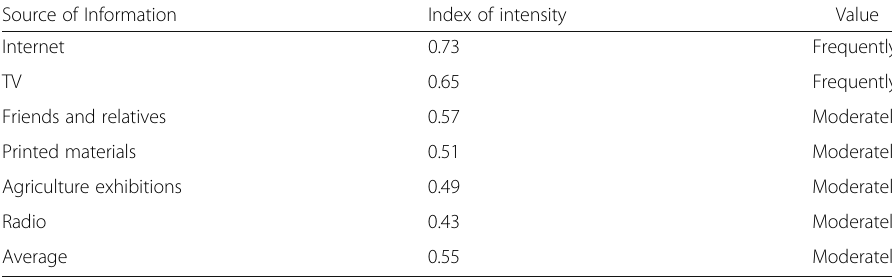
Table 9 Sources of information on organic